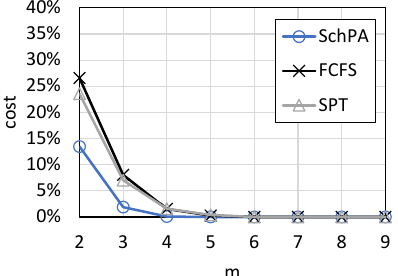
Figure 11. Comparison under varying m .